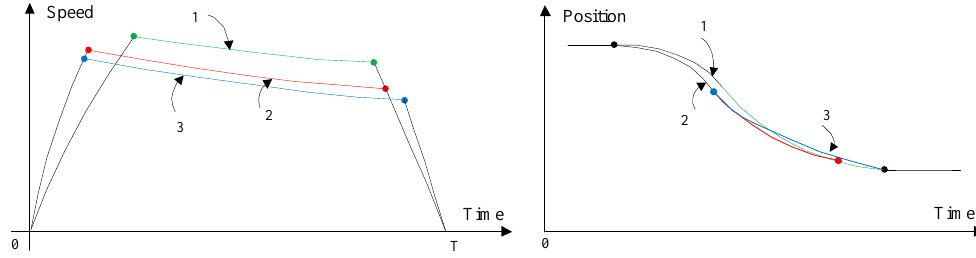
Figure 8. Driving strategy with different maximum traction and braking